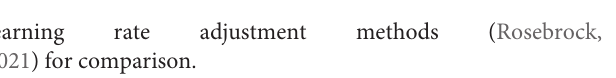
learning rate adjustment methods (Rosebrock, 2021) for